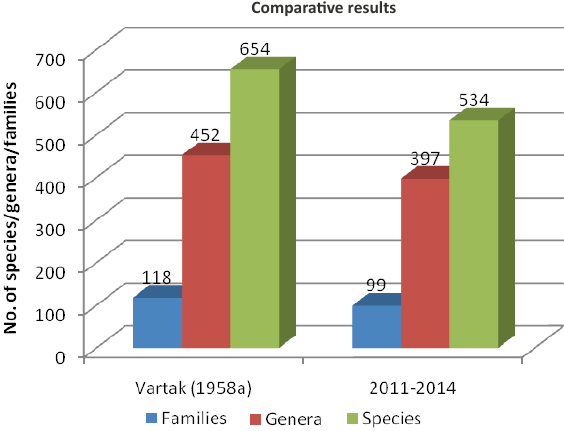
Figure 3. Comparitive floristic analysis of the present and past flora. P.S.- The recent taxonomic changes have not been incorporated in the analysis of Vartak (1958) due to absence of raw data and thus the values are not ammended. Thus this comparison should not be considered as final unless the two datasets are comparable taxonomically.